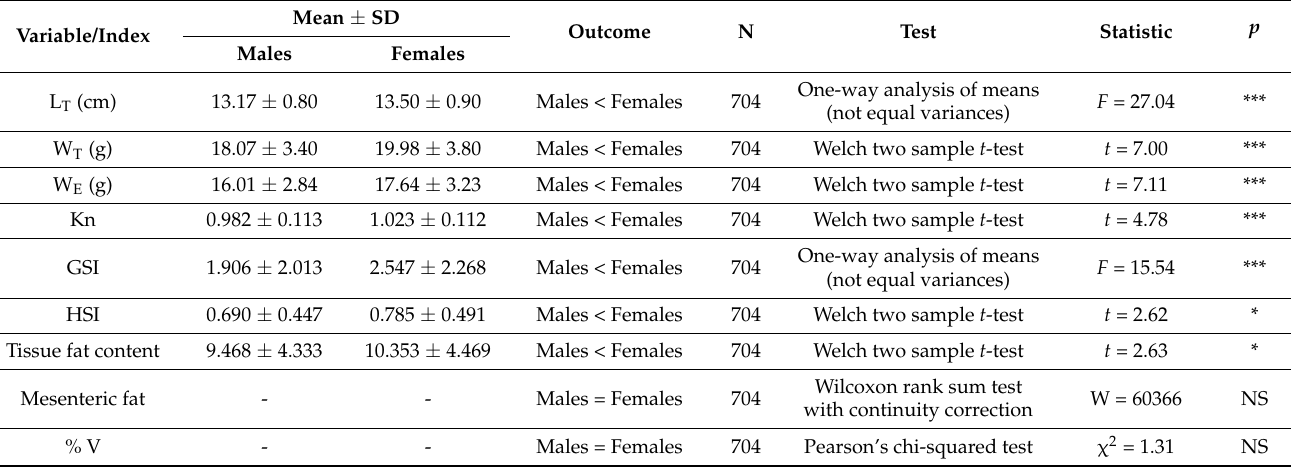
Table 1. Summary of the variables/indices comparing males and females of the European sardine ( S. pilchardus ) in the Gulf of Trieste. L T : total length (cm); W T : total weight (g); W E : eviscerated weight (g); Kn: relative condition index; GSI: gonadosomatic index (%); HSI: hepatosomatic in- dex (%); % V: stomach vacuity index (%). Significance values: p < 0.05 *; p < 0.0001 ***; NS (not statistically